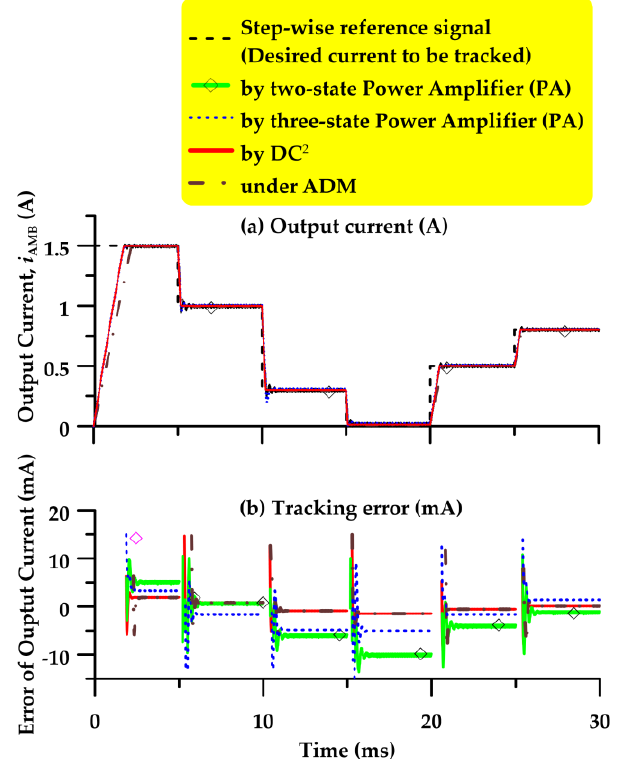
Figure 9. Output currents and tracking errors by three-state PA (power amplifier), DDM (digital driving mode), ADM (analog driving mode) and DC 2 (dual cooperative drive circuit).